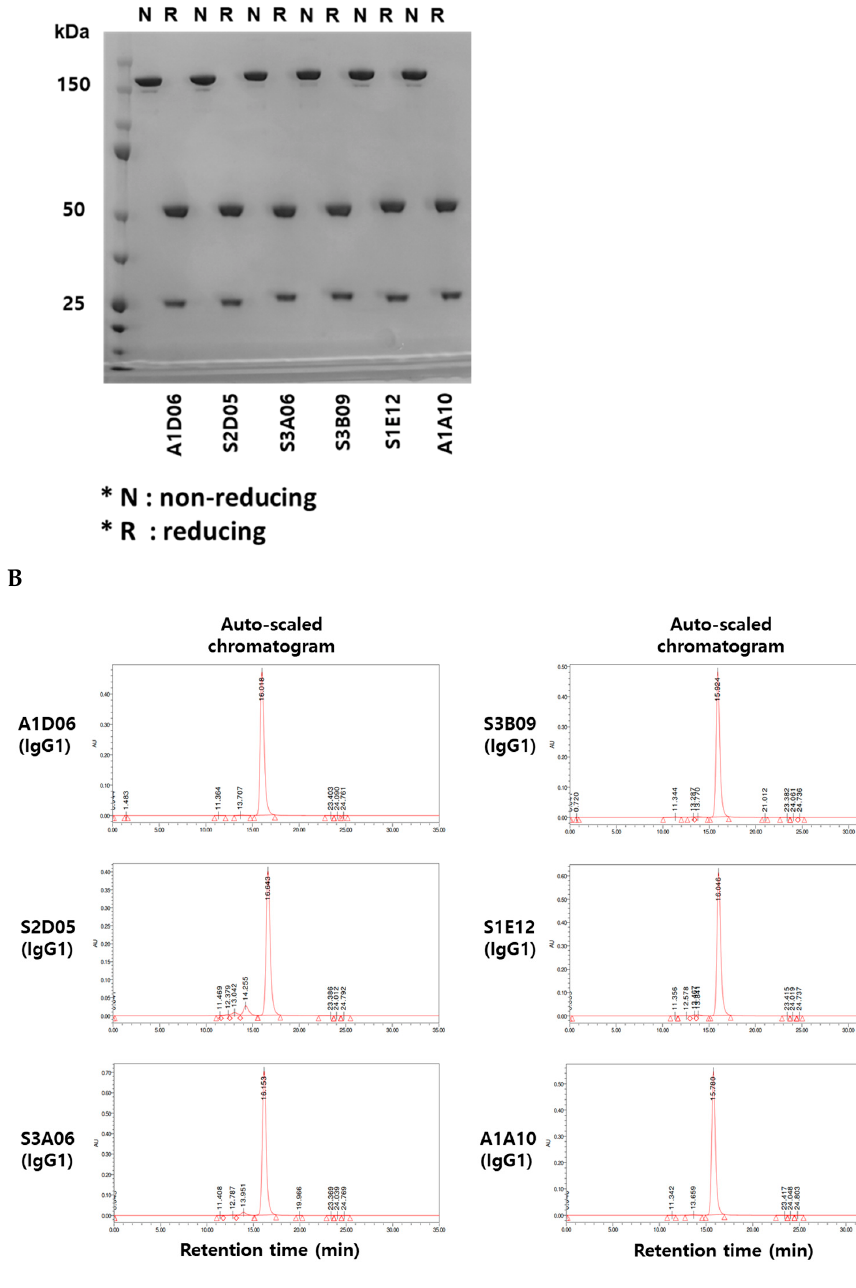
Figure 4. Physicochemical property analysis of anti-FGFR3 antibodies derived from cell panning. ( A ) Sodium dodecyl sulfate polyacrylamide gel electrophoresis (SDS-PAGE) analysis of purified antibodies in non-reducing and reducing conditions. In the non-reducing condition, 150 kDa band indicates the whole IgG, and in the reducing condition, 25 kDa and 50 kDa indicate the light chain and heavy chain of the antibody, respectively. ( B ) The purity of the anti-FGFR3 antibodies were analyzed using size exclusion-high performance liquid chromatography (SEC-HPLC). All anti-FGFR3 antibodies showed more than 95% purity of monomer.